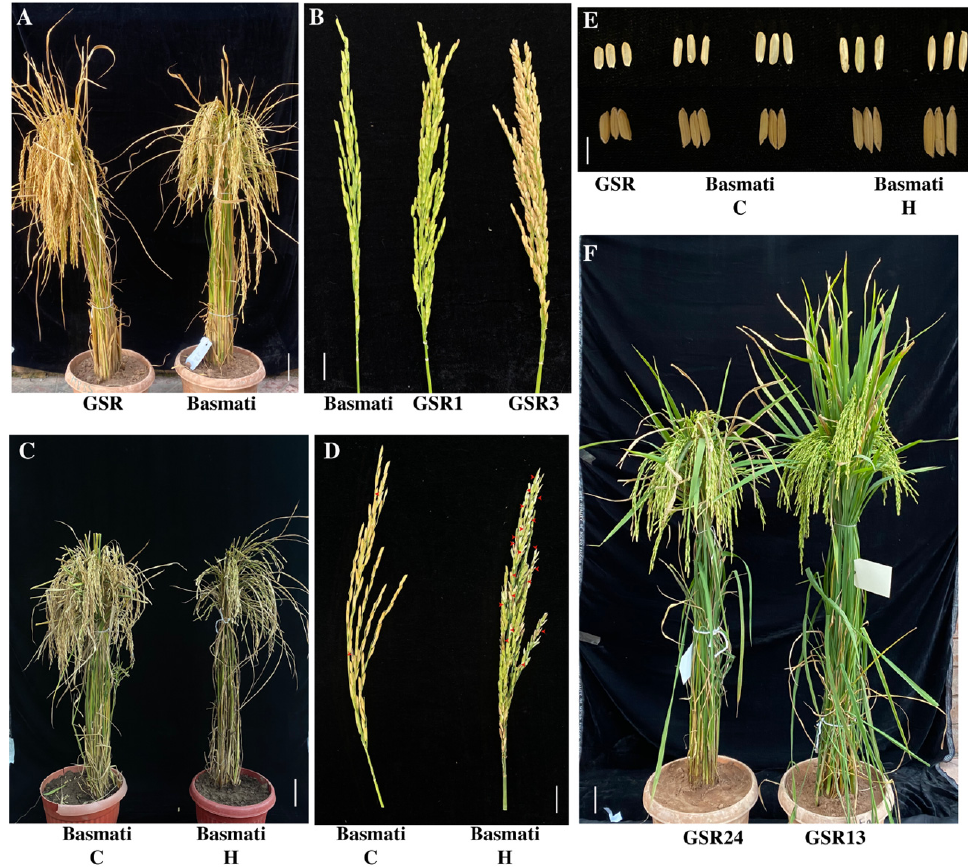
Figure 7. Salient features of GSR and basmati lines. ( A ) Comparison of GSR and basmati lines under control conditions. ( B ) Panicle comparison of basmati and GSR lines. ( C , D ) Basmati lines under control and heat stress conditions. ( E ) Seed comparison and ( F ) the effect of disease on GSR lines. Bars ( A , C , F = 10 cm; B , D = 1 cm; E = 1 mm).